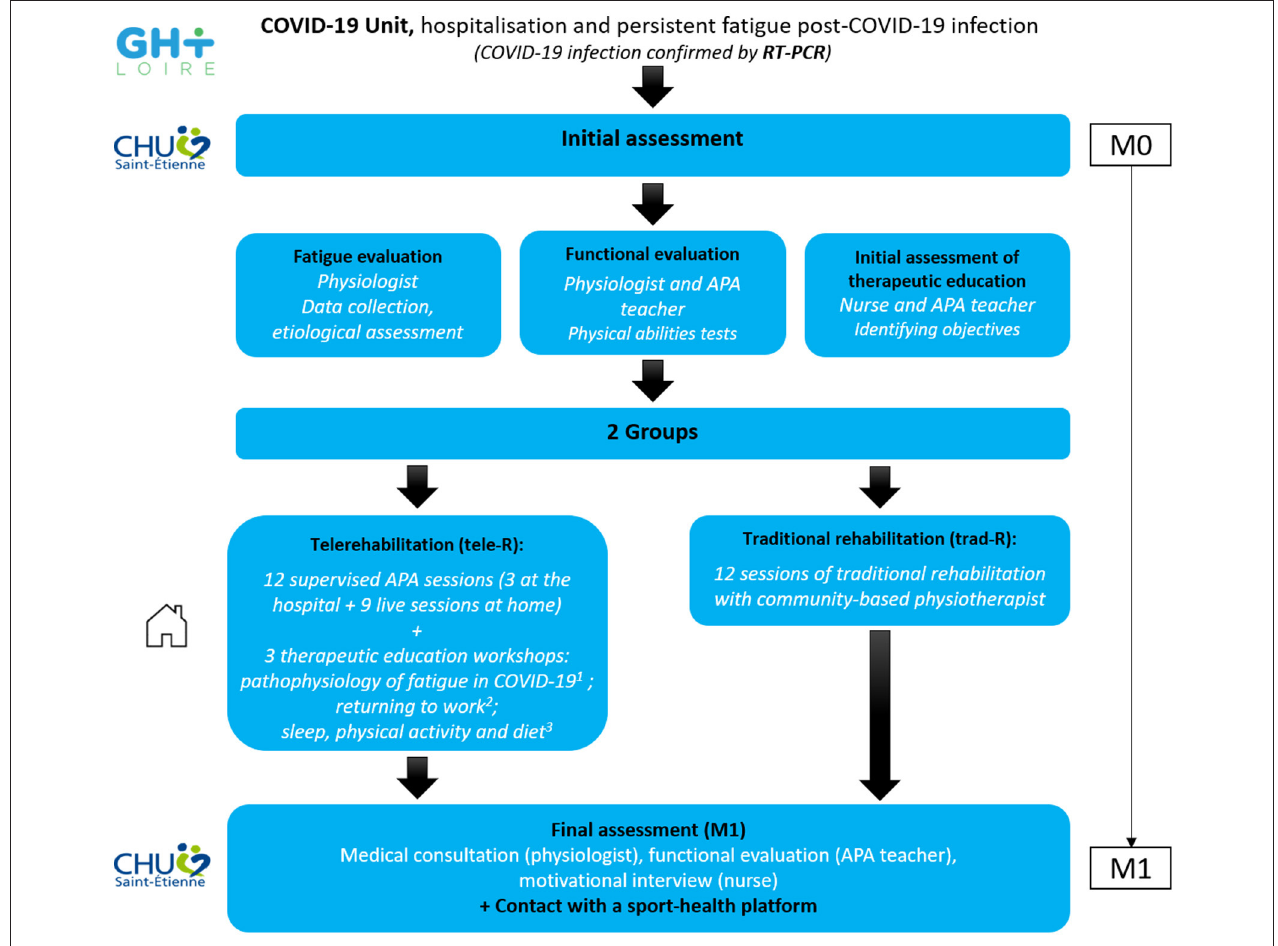
FIGURE 1 | Experimental design of the CoviMouv’ study. Pathway of the patients involved in the protocol. 1 Performed by Internal Medicine or Infections Department. 2 Performed by Occupational Health Department. 3 Performed by Physiology Department. RT-PCR, reverse transcription polymerase chain reaction; APA, adapted physical